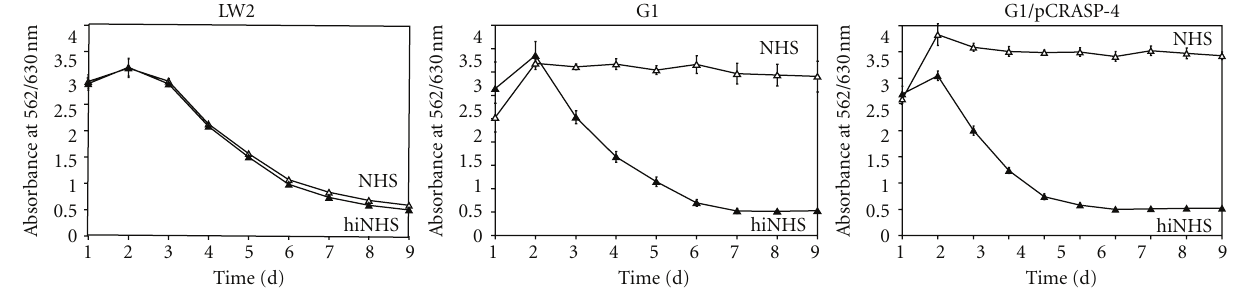
Figure 5: Serum susceptibility of transformed B. garinii G1. A growth inhibition assay was used to investigate susceptibility to human serum of B. burgdorferi strain LW2 and B. garinii strains G1 and G1/pCRASP-4. Spirochetes were incubated in either 50% NHS (open triangles) or 50% heat-inactivated NHS (filled triangles) over a cultivation period of 9 days at 33 ◦ C, respectively. Color changes were monitored by measurement of the absorbance at 562/630 nm. All experiments were performed three times during which each test was done at least in triplicate with very similar results. For clarity only data from a representative experiment are shown. Error bars represent ± SD. Taken together, binding of CFHRs by CRASP-4